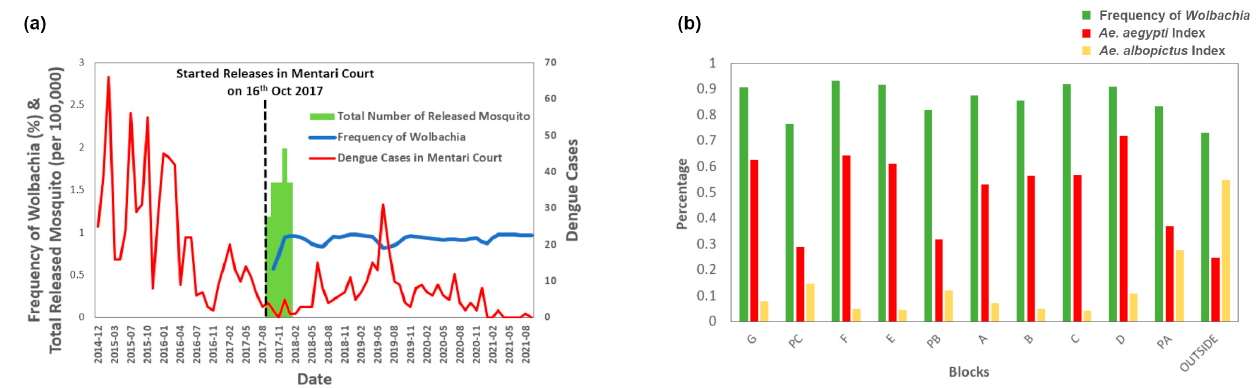
Figure 2. ( a ) Frequency of Wolbachia , dengue cases in Mentari Court before and after release and total released mosquitoes, and ( b ) average frequency of Wolbachia , the Ae. aegypti index, and the Ae. albopictus index in Mentari Court by blocks from 16 October 2017 to 5 October 2021.